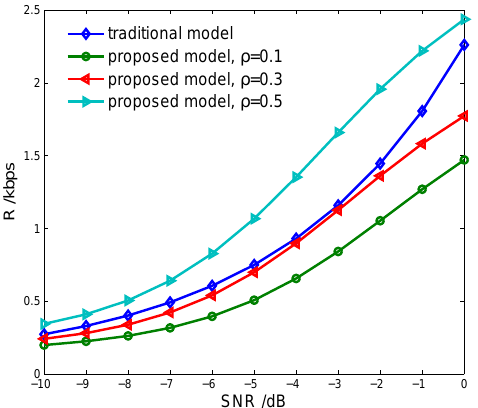
Figure 7. Throughput versus spectrum sensing models. SNR: signal to noise ratio.